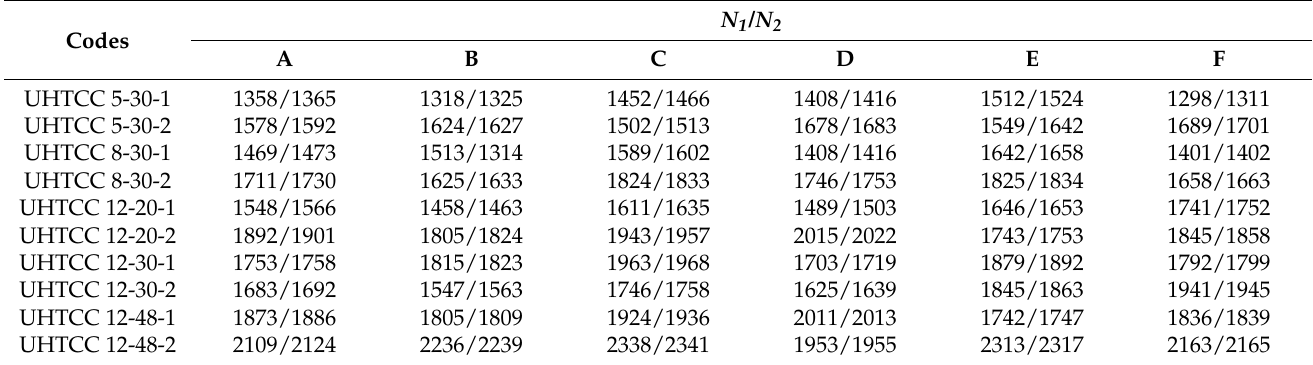
Table 4. The number of impacts at the initial cracking of the specimen is N 1 , and the number of impacts at the final cracking is N 2 .